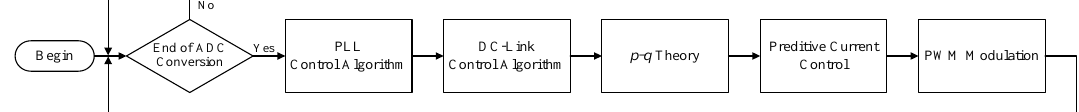
Figure 20. General flowchart of the control system implemented in the DSC.